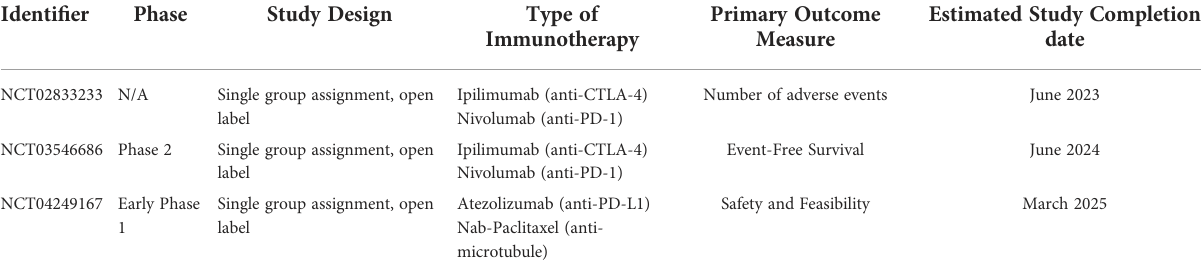
TABLE 1 Ongoing Clinical Trials of Combined Cryoablation with Immune Checkpoint Inhibitors for the Treatment of Breast Cancer. Identi fi er Phase Study